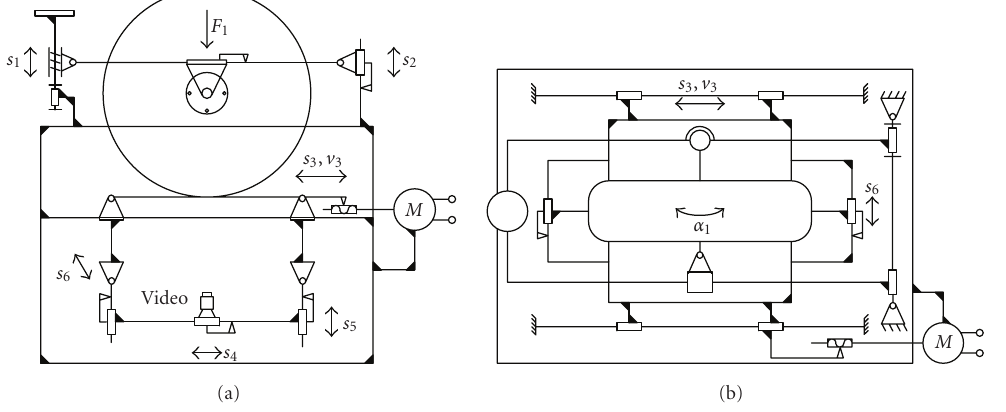
Figure 1: Schema of tire test rig [15].